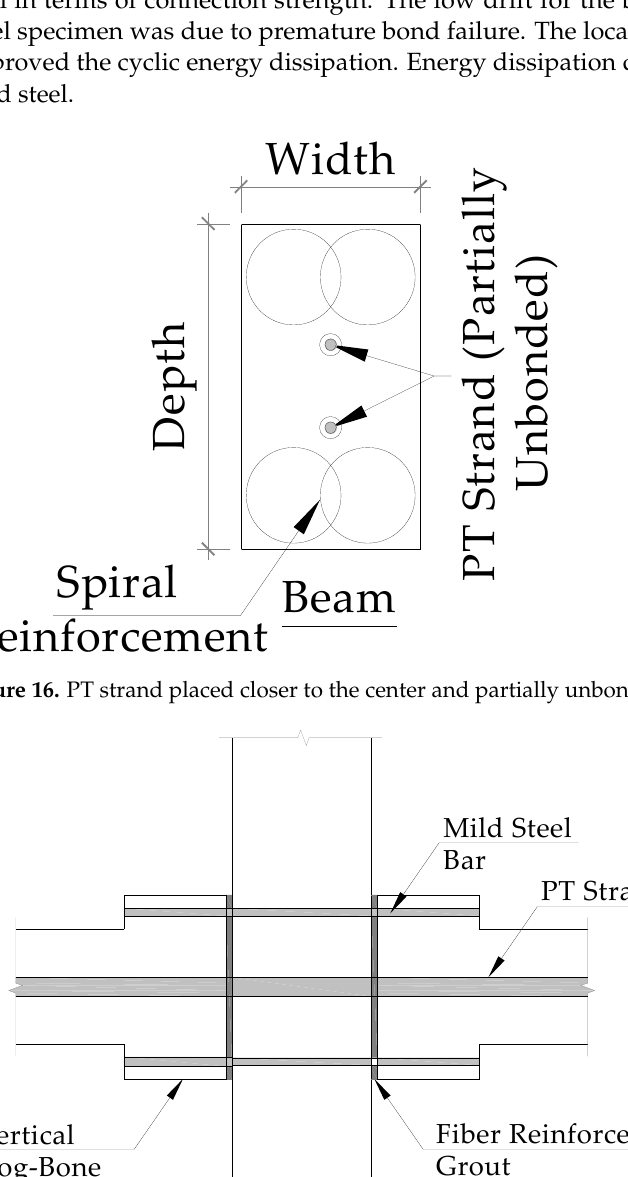
Figure 18. Five test specimens with various variables. In Phase IV-B, Cheok and Stone (1994) [13] experimented with precast beam column assembly (Figure 19) using four beam specimens, as shown in Figure 20. Unbonded post- tensioning steel and a bonded mild steel bar were used. The variables were the amount and type of low-strength steel. Crack widths reported in both the column and beams were very small. The closure of gap openings at column–beam interface was zero, even at 3.5% story drift. Specimen M-P-Z4 failed due to the fracture of mild steel bars. PT steel in this specimen was 0.93 fpu, indicating it remained elastic throughout the test. Loss in PT steel was 0.06 fpu. Hence clamping force was maintained.